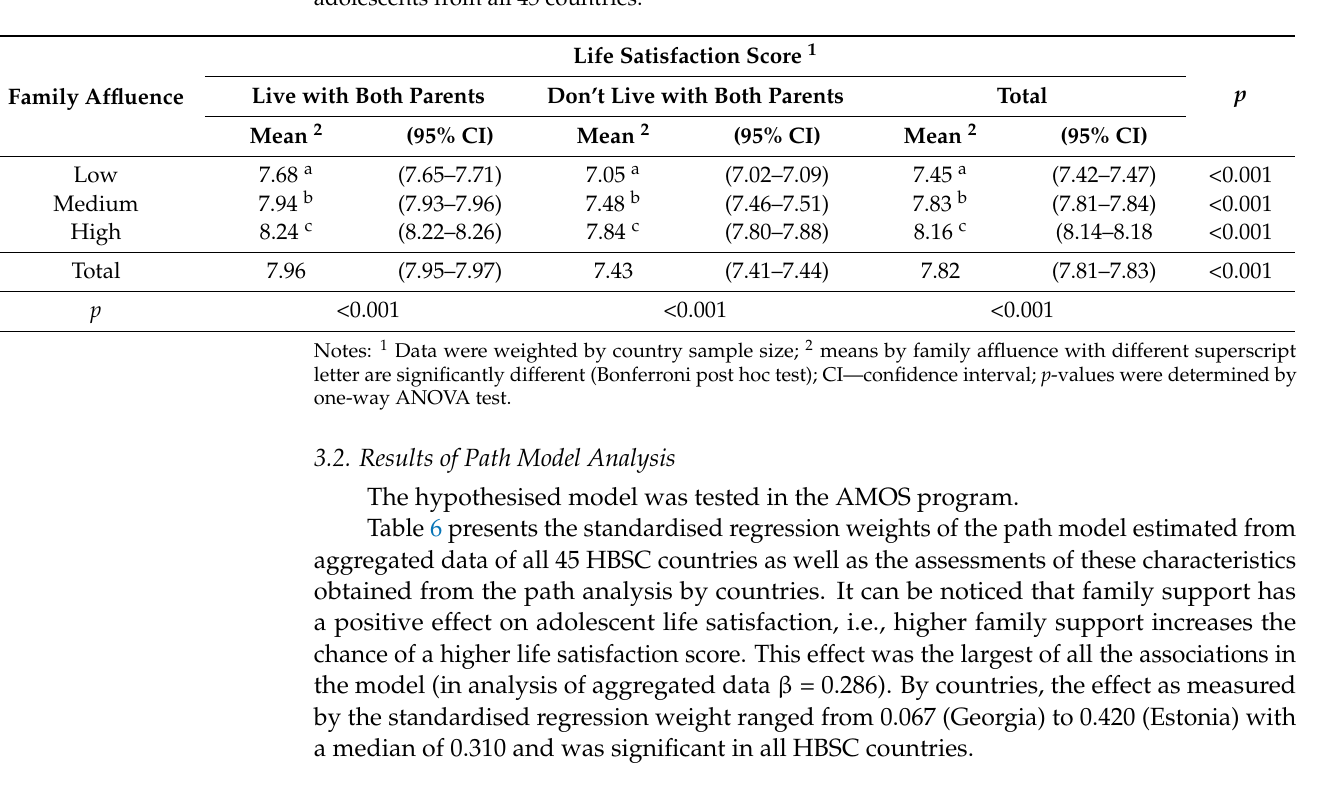
Table 5. Summary data on life satisfaction association with family affluence and family structure in adolescents from all 45 countries.